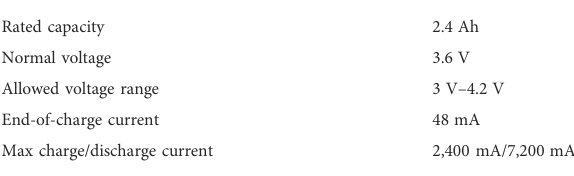
TABLE 1 Speci fi cations of the experimented